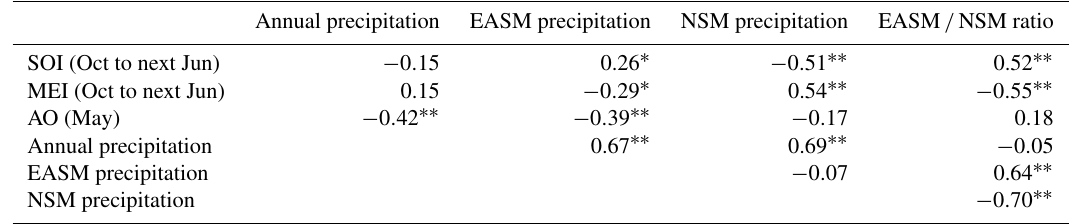
Table 3. Correlation coefficients between the time series of the MEI; the EASM / NSM ratio; and the annual, EASM, and NSM precipitation amounts in the SPR region for 1951–2010. The temporal coverage of the annual precipitation and the δ 18 O w is from May to next April, the EASM precipitation is from May to September, and the NSM precipitation is from October to next April. The temporal coverage of the SOI and MEI is from October to next